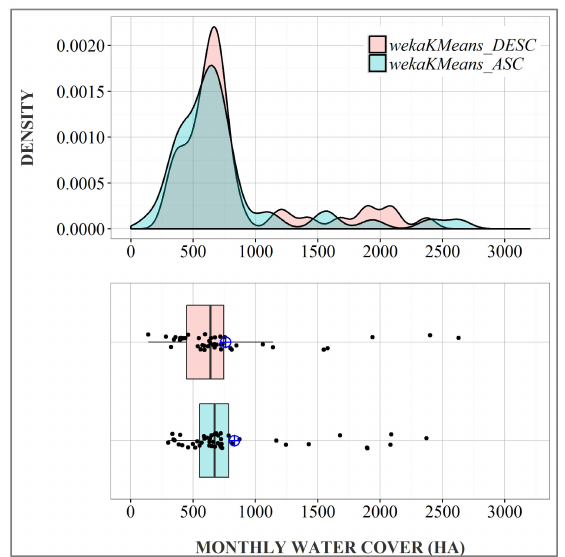
Figure 5. Density function (top) and box plot (bottom) of monthly water coverage—(WEKA K-Means_DESC-water coverage obtained from the classification of images captured on the descending path; WEKA K-Means_ASC—the same procedure for the ascending path. The blue represents arithmetic averages.